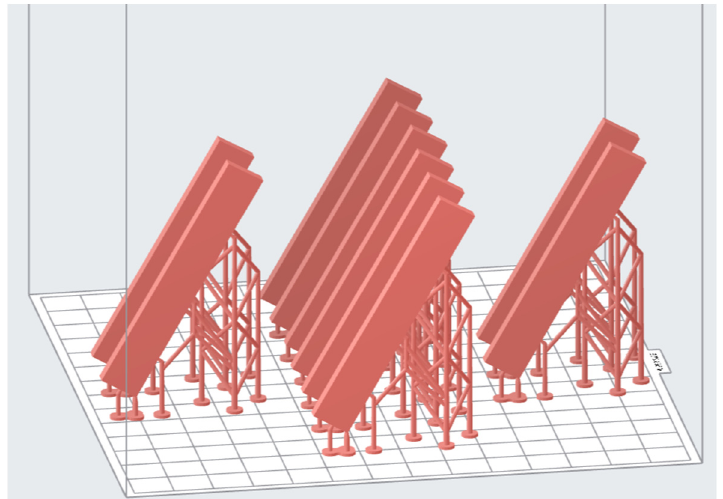
Figure 1. Specimens design exported to slicer. Table 2. Three-dimensional printers to represent the different vat polymerization techniques.